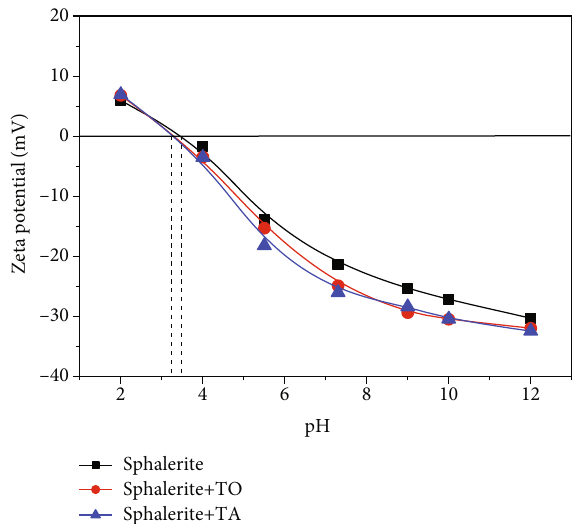
Figure 9: E ff ect of TO or TA on the zeta potential of sphalerite (TO: 10mg/L; TA: 10